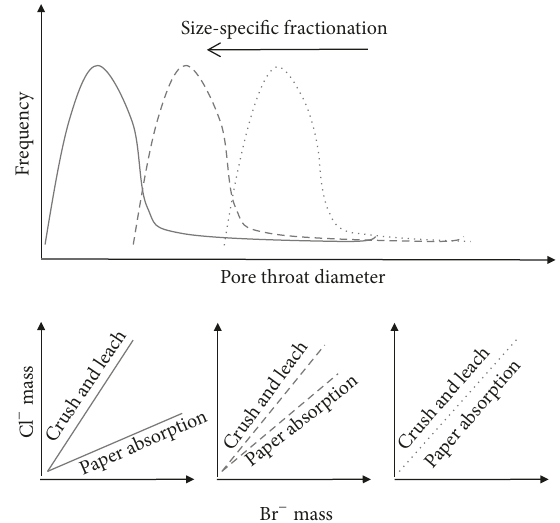
Figure 9: Conceptual model depicting the fractionation of Br − from Cl − due to size-specific anion exclusion and the relationship to pore throat diameter.